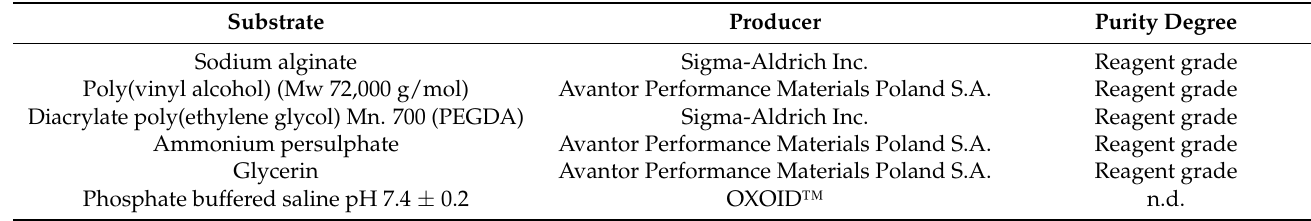
Figure 9. Fibroblast cells stained with CellTracker Green attached to the surface of the hydrogel discs; ( a ) sample S2G0; ( b ) sample S2G0.5; ( c ) sample S2G1. Scale bars indicate 25 µm.